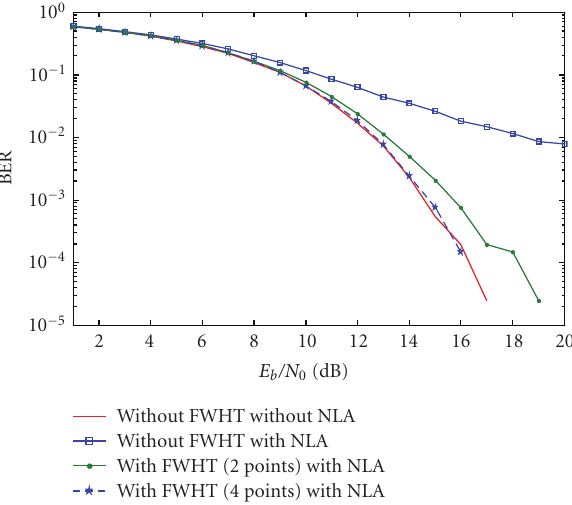
Figure 16: E ff ect of NLA on BER with/without